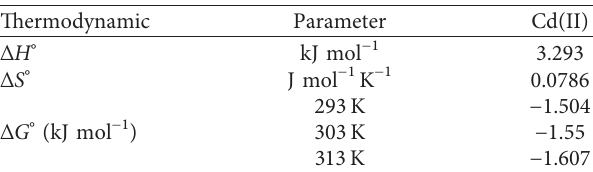
Figure 5: Correlating the initial concentration of Cd(II) ions with hopping number ( n ) as operating temperature increased. Table 4: Thermodynamic parameters of G-3 PAMAM SGA for Cd(II)